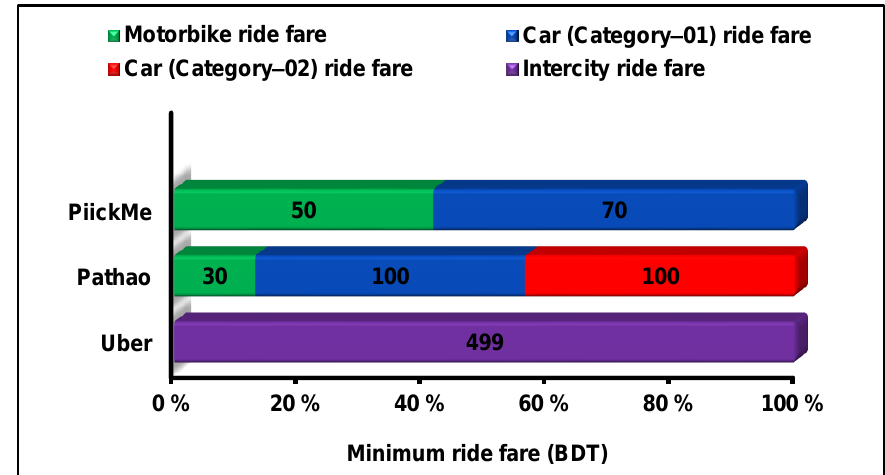
Fig. 9. Comparison based on minimum ride